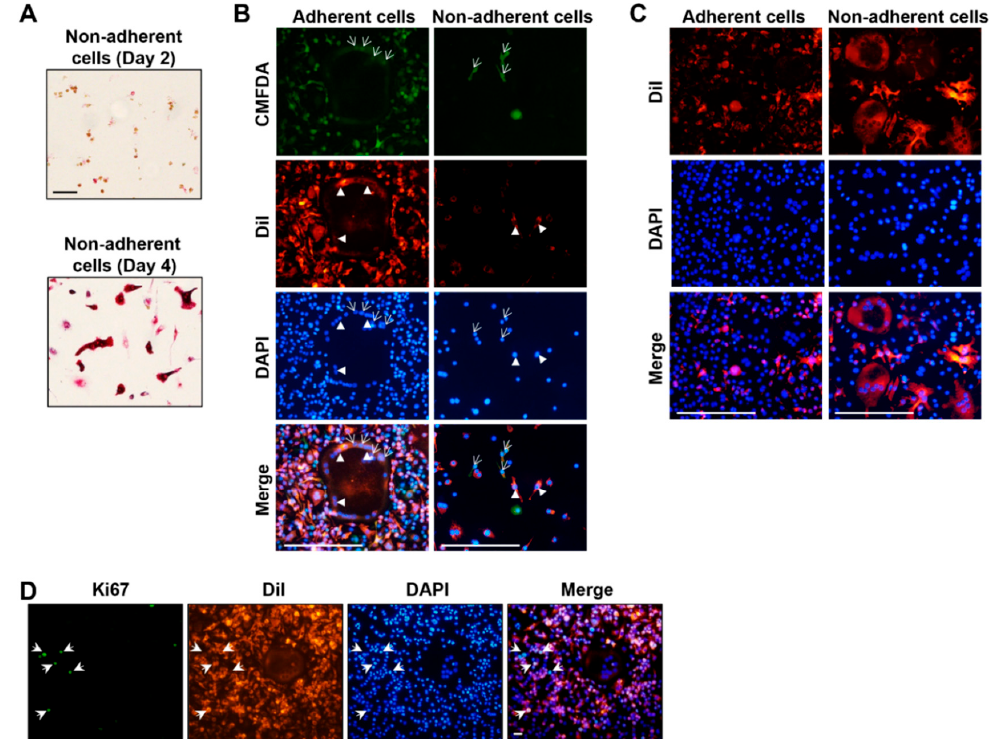
Figure 4. SNCs are osteoclast-committed cells. ( A ) Suspended SNCs were collected on day 2 following RANKL stimulation and then recultured in RANKL-containing medium for an additional 2 days (day 4). The cells on days 2 and 4 were fixed and stained with TRAP to determine the mature osteoclasts. Scale bar, 100 µm. ( B ) Adherent cells or non-adherent cells were collected on day 2 of RANKL stimulation. Two cell populations stained separately with CMFDA (arrows) or DiI (arrow heads) were co-cultured for 3 days in RANKL-containing medium. The cells were fixed, and fusion was detected. Scale bar, 100 µm. ( C ) DiI-stained adherent (left panel) or non-adherent (right panel) cells on day 2 following RANKL stimulation were co-cultured with unstained adherent cells for 2 days with RANKL stimulation Scale bar, 100 µm. ( D ) Cell proliferation was determined based on Ki67 (arrows) immunostaining on day 4 after RANKL stimulation. Scale bar, 20 µm.